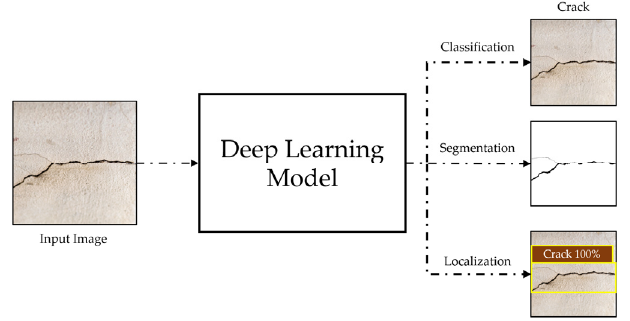
Figure 1. Representation of the output of the deep learning